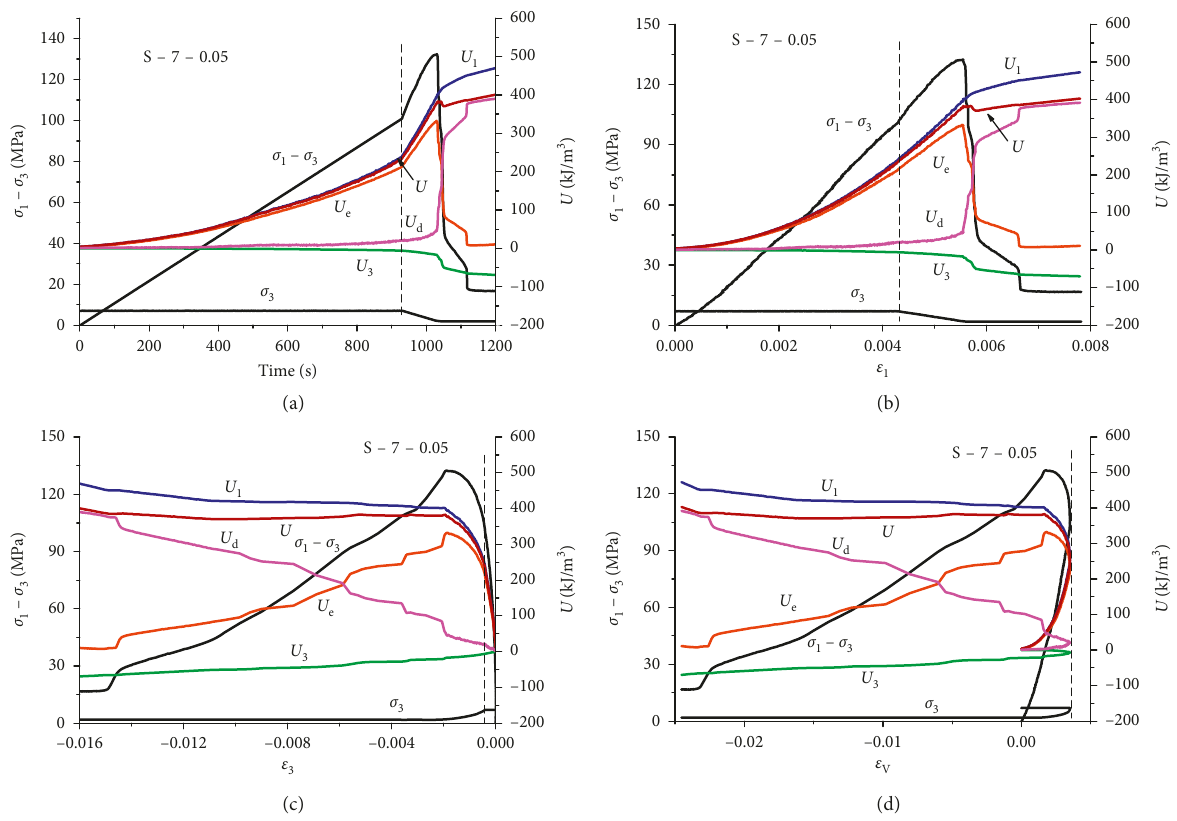
Figure 5: Energy evolution curves of sandstone samples under unloading confining pressure. (a) Energy-time curve (C-7-0.05). (b) Energy- axial-strain curve (C-7-0.05). (c) Energy-radial-strain curve (C-7-0.05). (d) Energy-volume-strain curve